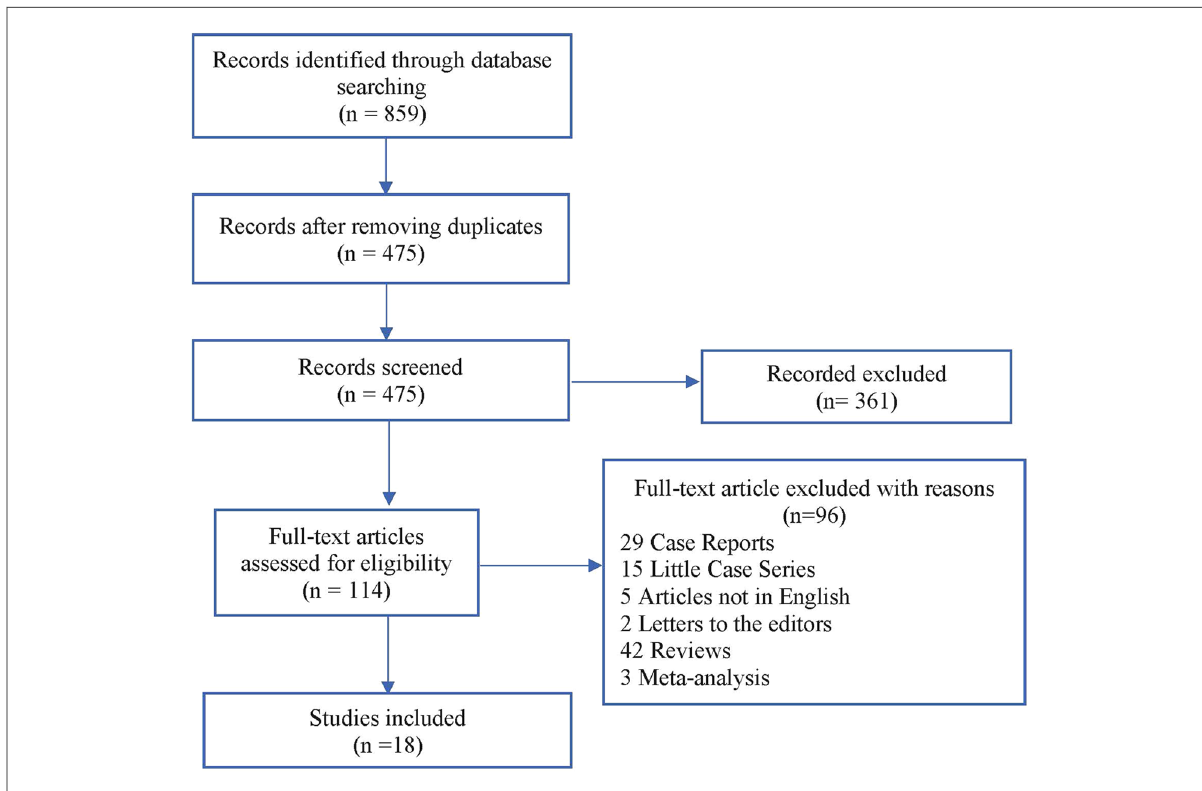
FIGURE 1 Flow chart (PRISMA guidelines) of the reviewed